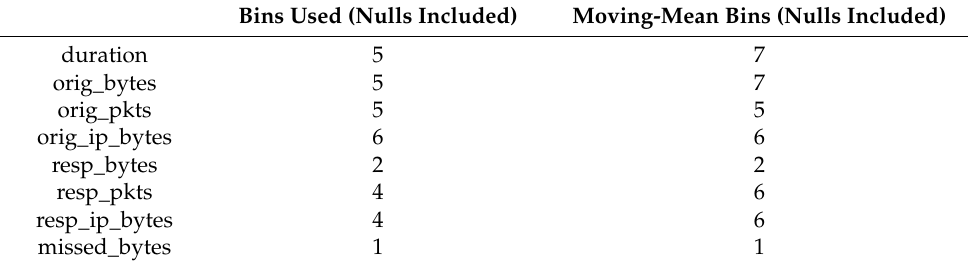
Table 5. Number of bins for continuous attributes before and after moving-mean. Bins Used (Nulls Included)